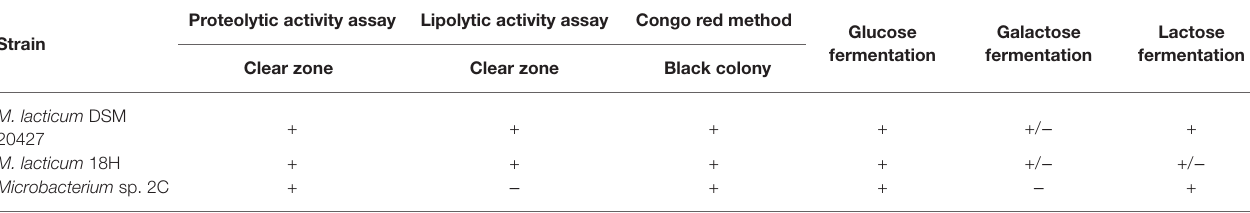
TABLE 3 | Summary of the phenotypic characterization of the Microbacterium strains.